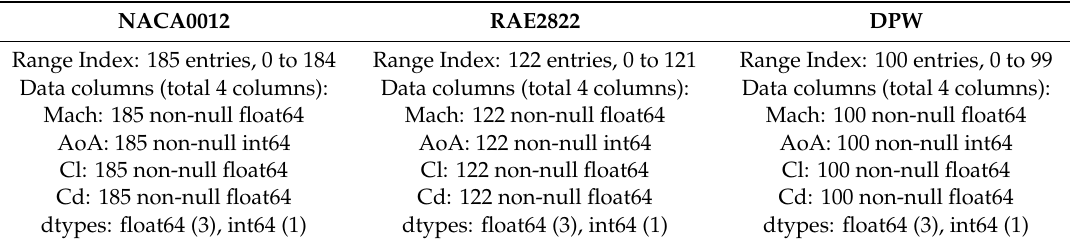
Table 2. Initial information of the aerodynamic databases.